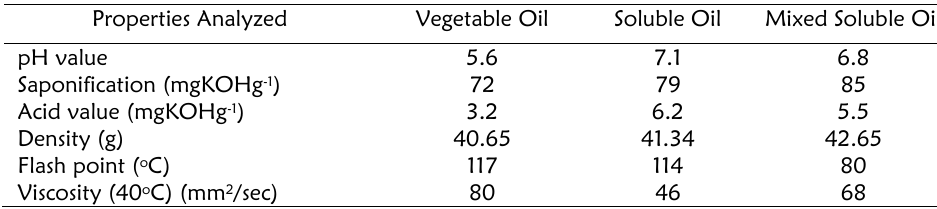
Table 1: Results of Physicochemical Analysis